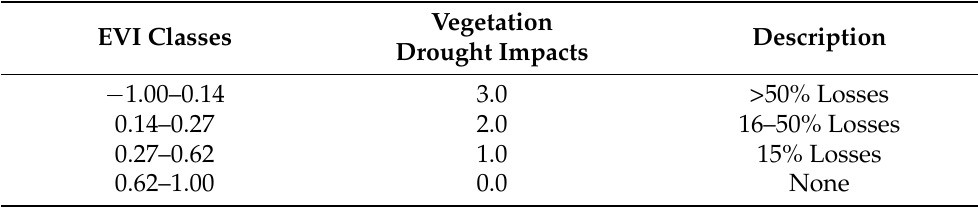
Table 2. Transformation from EVI spatial values to Drought Impacts